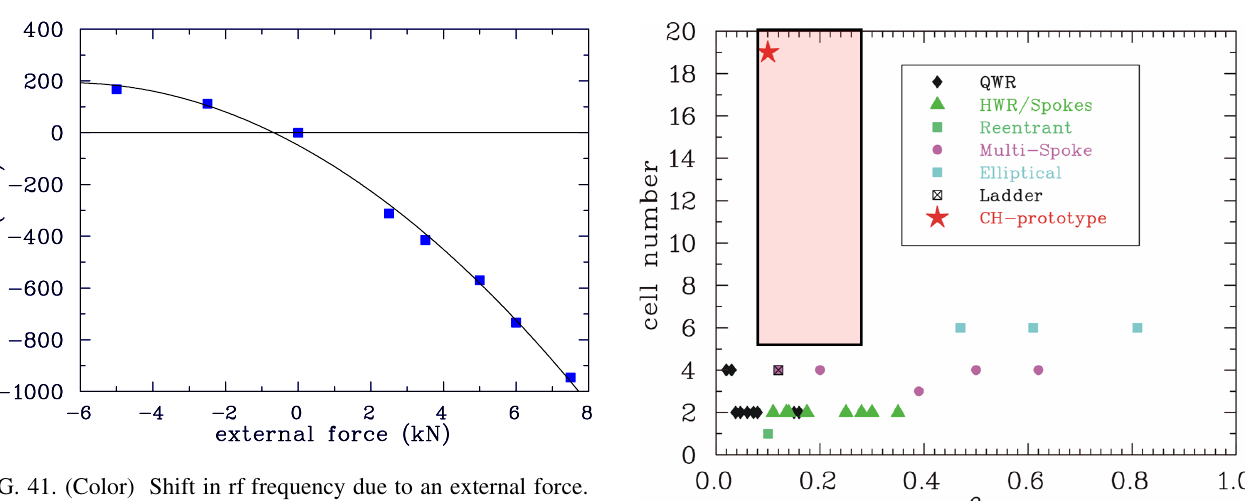
FIG. 41. (Color) Shift in rf frequency due to an external